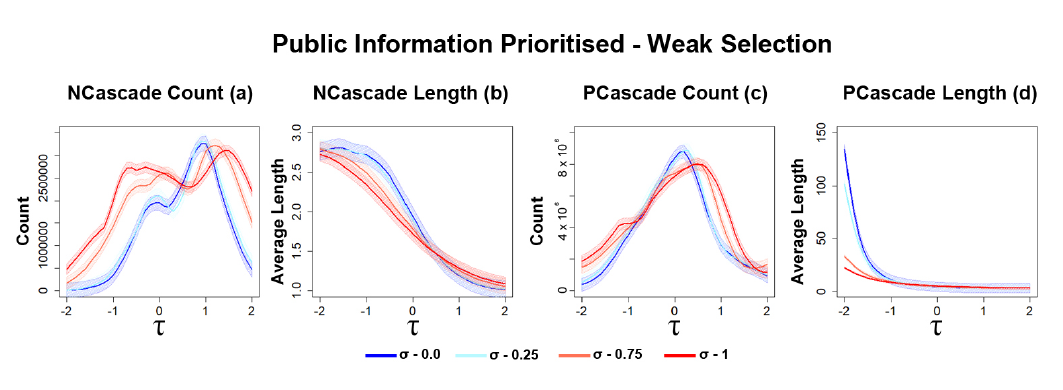
Figure 13. Significant increases in cascades occur when public information is prioritised. For both cascade types, each graph represents either the number or average length of each cascade type. Data obtained by running the model for 10 8 steps with p = 0.75 and q = 0.25 and a δ setting of 0.001. σ represents opinion diversity. Shading represents level of standard error calculated for each dataset. Data interpolated utilising RStudio [22]. Plots produced via RStudio utilising code found in Appendix A.